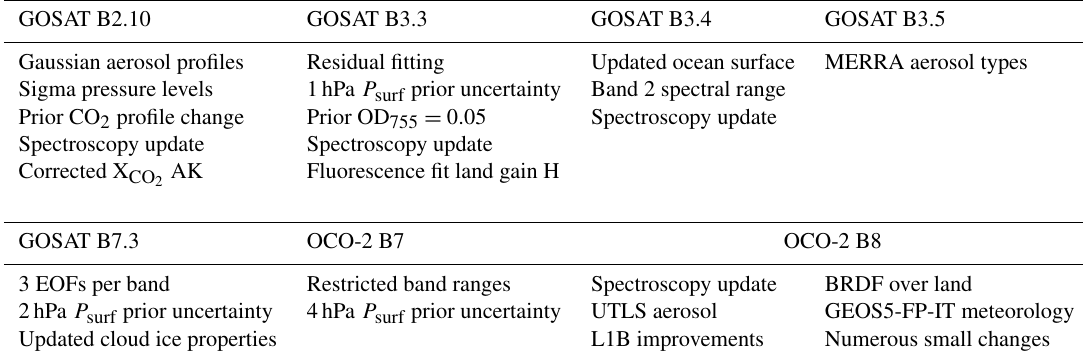
Table 3. Significant ACOS retrieval algorithm